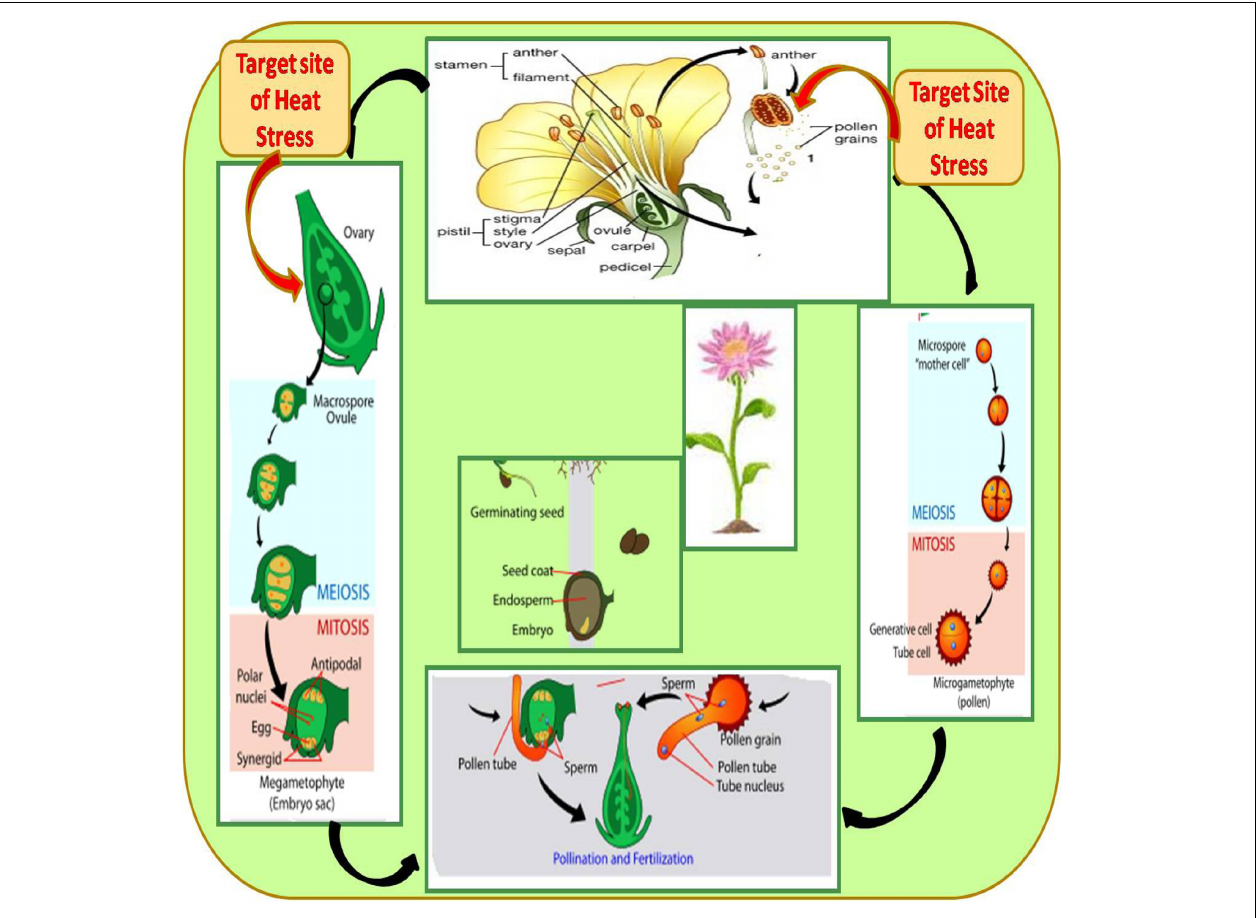
FIGURE 3 | The life cycle of a typical angiosperm showing target sites of heat stress. The sporophyte phase is the main phase, which generates microspores that produce pollen grains as the male gametophytes (microgametophyte), and megagametophytes (megaspores), which form an ovule that contains female